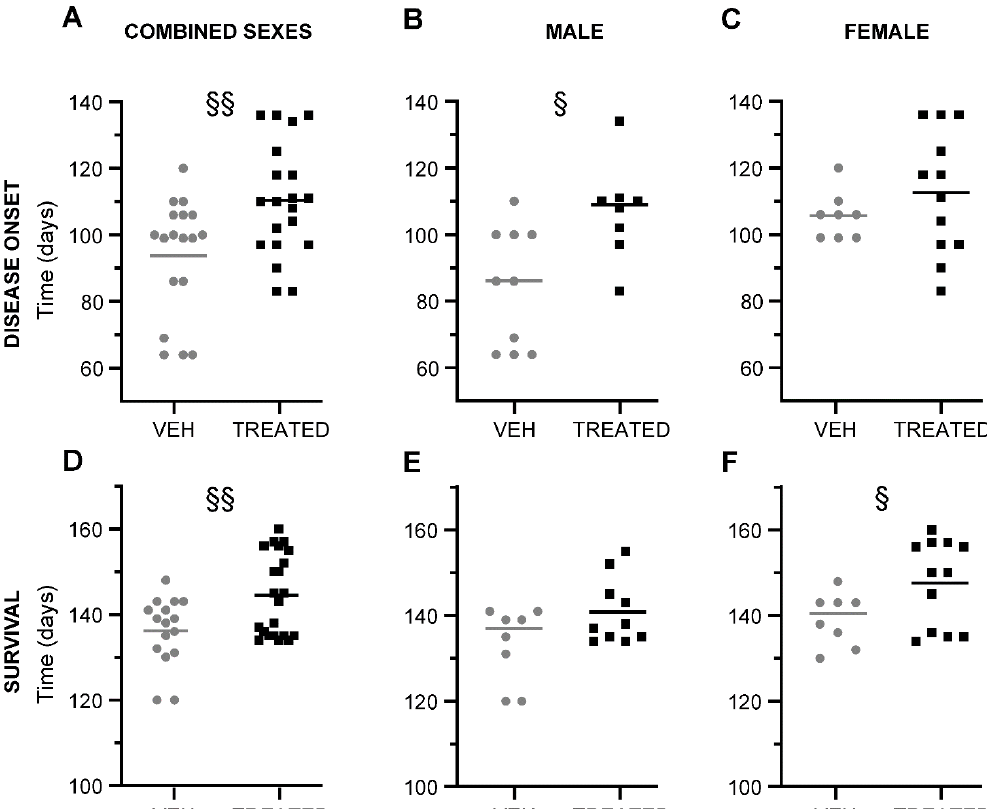
Figure 3. Disease onset and survival of combined sexes, male and female SOD1(G93A) mice in TREATED and VEH group: ( A ) The graph shows the disease onset of combined sex mice in the TREATED and VEH group. A significant delay in disease onset was observed in the TREATED animals compared to the VEH mice ( p = 0.0055; n = 18 VEH, 20 TREATED); ( B ) The male mice in the TREATED group showed a statistically significant delay of disease onset compared with the VEH, ( p = 0.0107; n = 10 VEH, 8 TREATED); ( C ) In the female animals, a trend was observed in the delay of disease onset of animals treated with the drugs, but was without statistical significance ( p = 0.3294; n = 8 VEH, 12 TREATED); ( D ) The graph shows the rate of survival of combined sexes in the TREATED group compared to the VEH. The treated mice showed a significant improvement in survival rate compared to the VEH ( p =0.0074; n = 16 VEH, 22 TREATED); ( E ) Male animals in the TREATED group displayed no significance in survival rate ( p = 0.0702; n = 8 VEH, 10 TREATED); ( F ) In the female mice, an improvement in the lifespan of treated animals was observed with respect to the VEH mice ( p = 0.0497; n = 8 VEH, 12 TREATED). Statistical analysis was performed with Log-rank (Mantel–Cox) test. Data in all graphs are expressed as mean ± SEM. § p < 0.05; §§ p < 0.005.